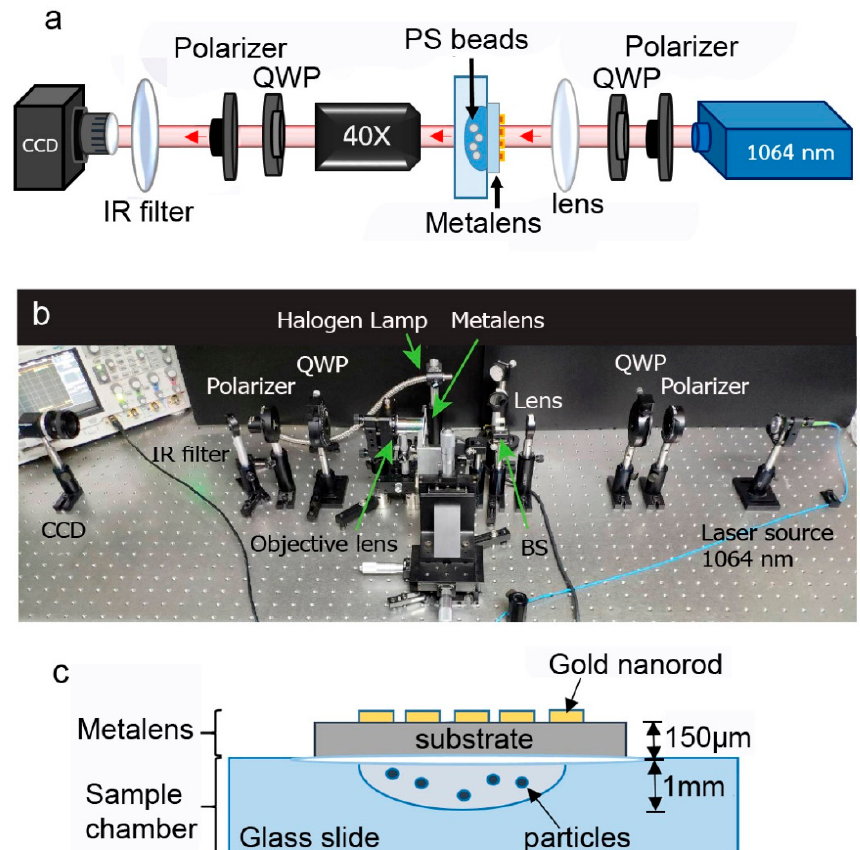
Figure 3. ( a ) An experimental setup diagram of metalens based on optical tweezers with ( b ) a laboratory setup illustrated. Note that a straight beam path from the laser to a CCD camera is for optical trapping and an illumination path with a halogen lamp as a light source is set on the side to enter the optical trapping path through a beamsplitter (BS). ( c ) Schematic sketch of the chambered glass slide, which was attached on top with metalens as a sample container.